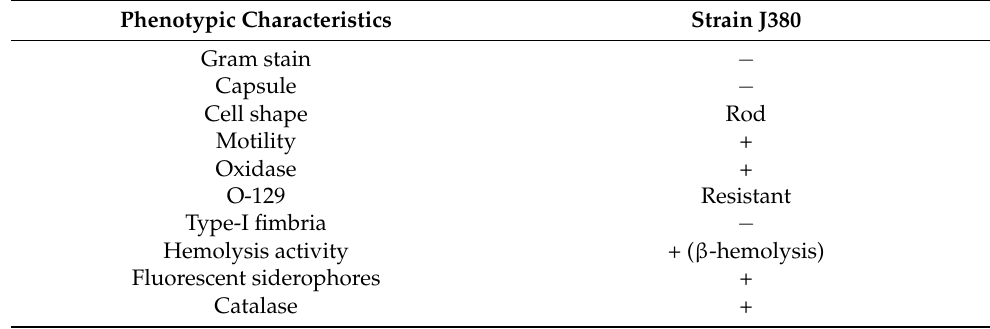
Table 1. Phenotypic characteristics of Pseudomonas sp. J380 strain isolated from wild cunner fish ( Tautogolabrus adspersus